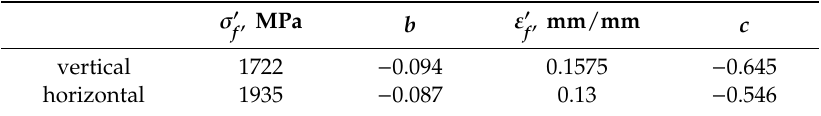
Figure 10. Experimental strain-life data fitted by Co ffi n-Manson for the investigated EBM Ti-6Al-4V specimens with ( a ) vertical and ( b ) horizontal build direction. Table 8. Analytical description of the strain-life curves for vertically and horizontally oriented specimens with parameters of the Co ffi n–Manson